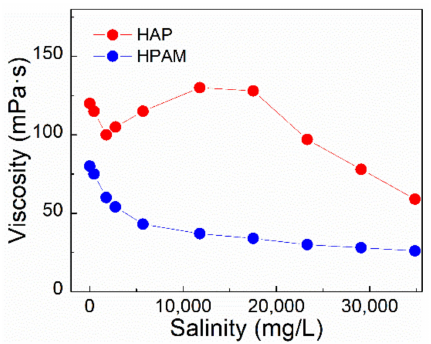
Figure 7. The effect of salinity on apparent viscosity of polymer solutions at 75 ◦ C. (Polymer concentration, 0.175%; shear rate, 7.34 s − 1